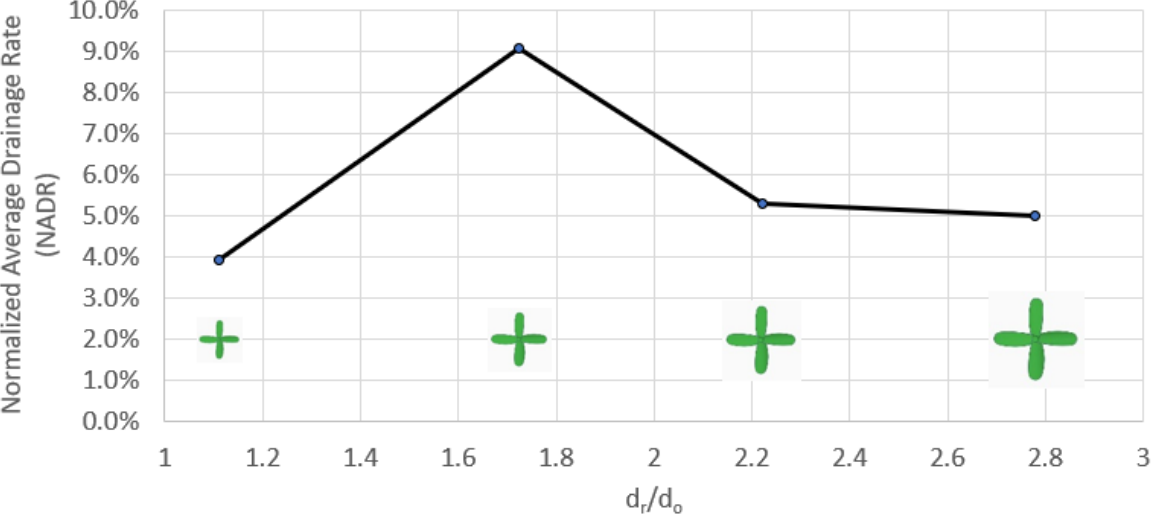
Figure 10. Effect of rotor size on the enhancement of tank drainage rate (4-blade rotors only).